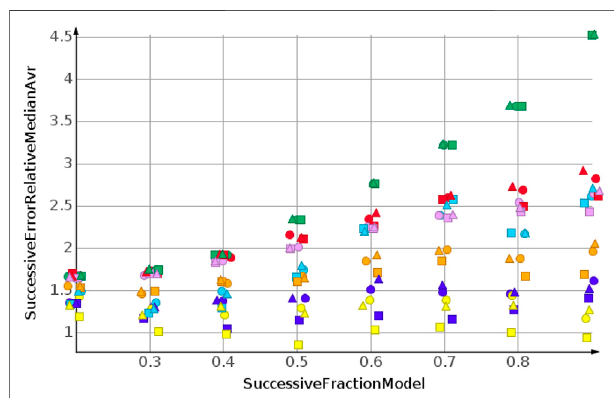
FIGURE 8 | cLogP, high to low sorted response values.